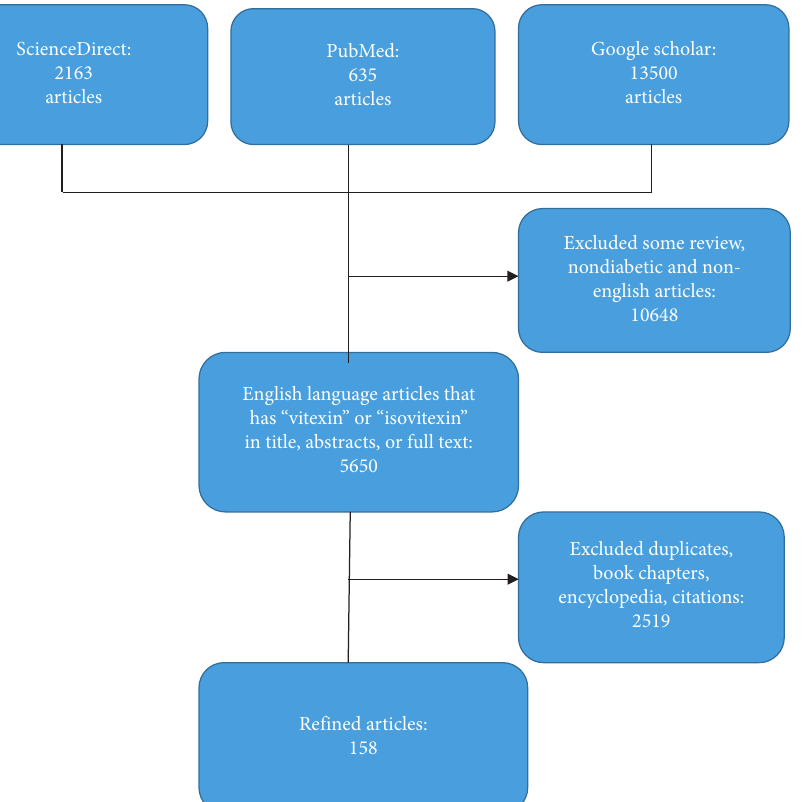
Figure 2: Flow chart of the search method and manuscripts